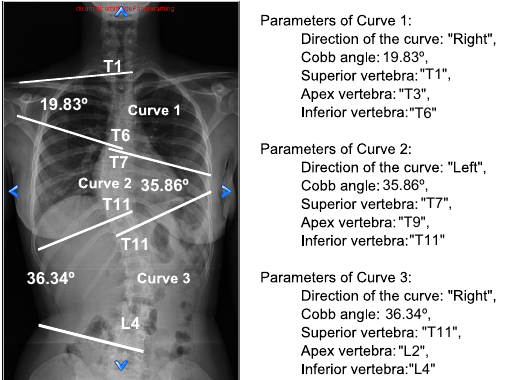
Fig. 2. Example of Cobb angle measurement for a spine with three curves. On the right, the parameter values for each